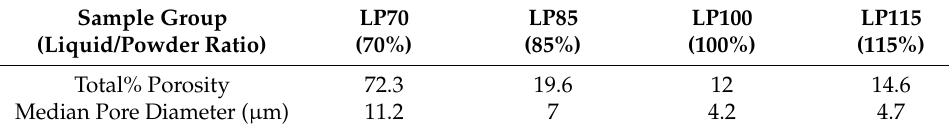
Table 4. Porosity of PMMA bone cement with different liquid/powder ratios.